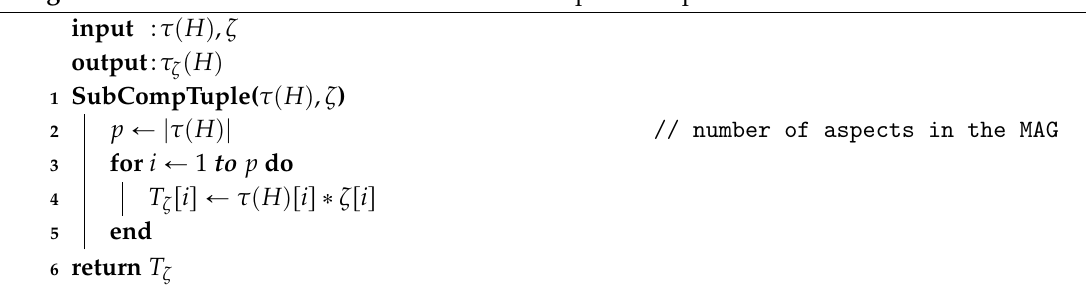
Algorithm 2: Construction of sub-determined companion